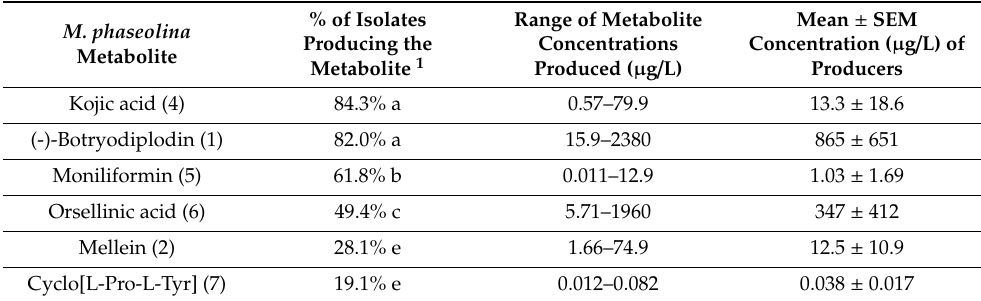
Table 2. Mycotoxins and other secondary metabolites occurring in the culture media of a relatively high percentage ( > 19%) of the 89 M. phaseolina isolates from soybean plants symptomatic for charcoal rot included in the